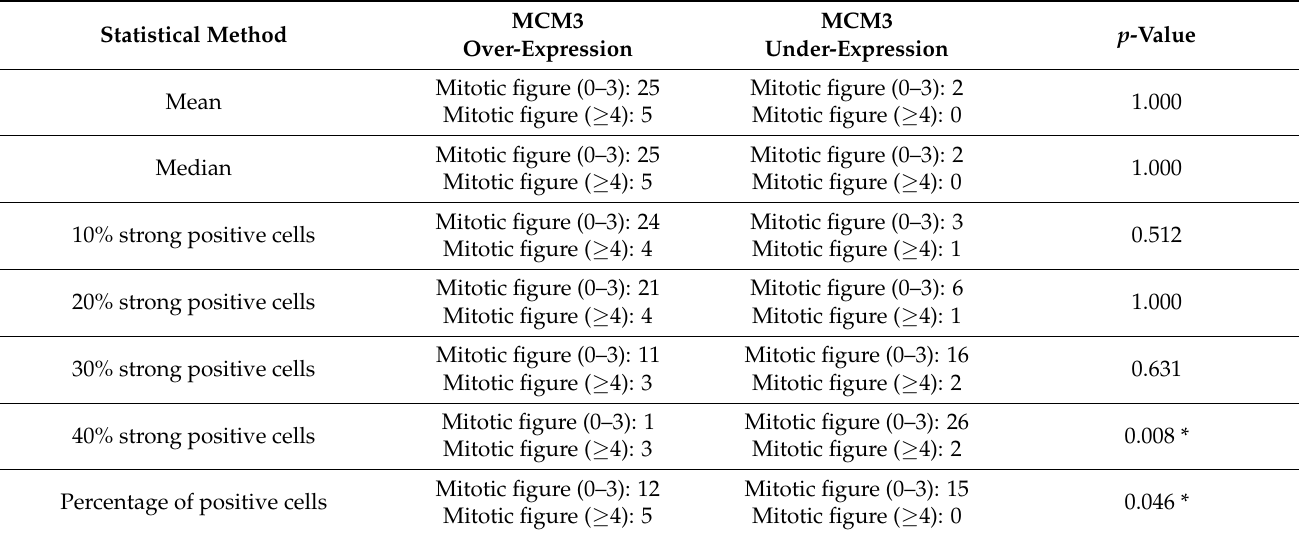
Table 9. MCM3 expression correlation with mitotic